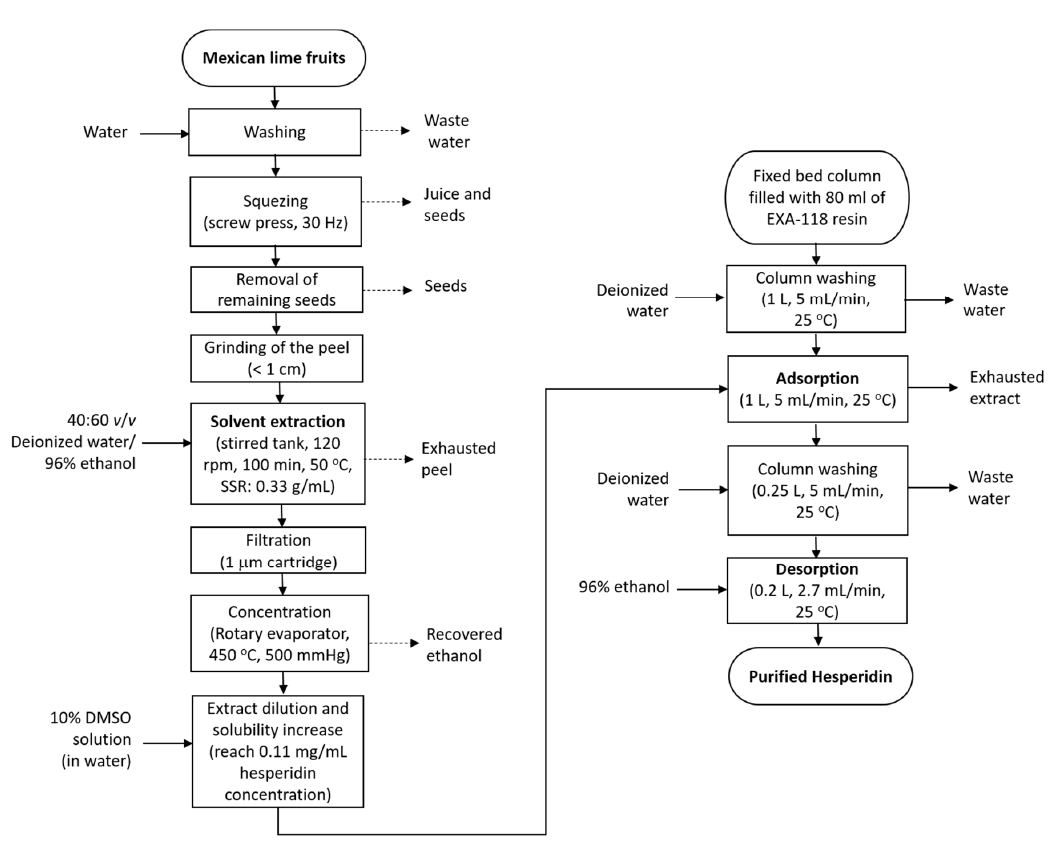
Figure 6. Hesperidin recovery efficiency during desorption.